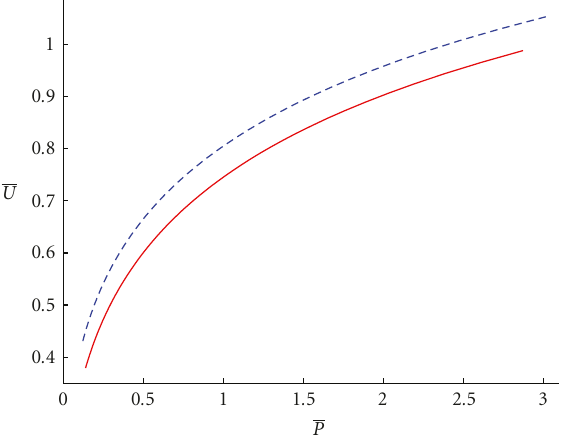
This approximate value function is separable, that is, a sum of functions of the individual flows, whereas the exact value function is (in general) not. The approximate policy, however, is not separable; the optimization problem solving to assign flow rates couples the di ff erent flow rates.